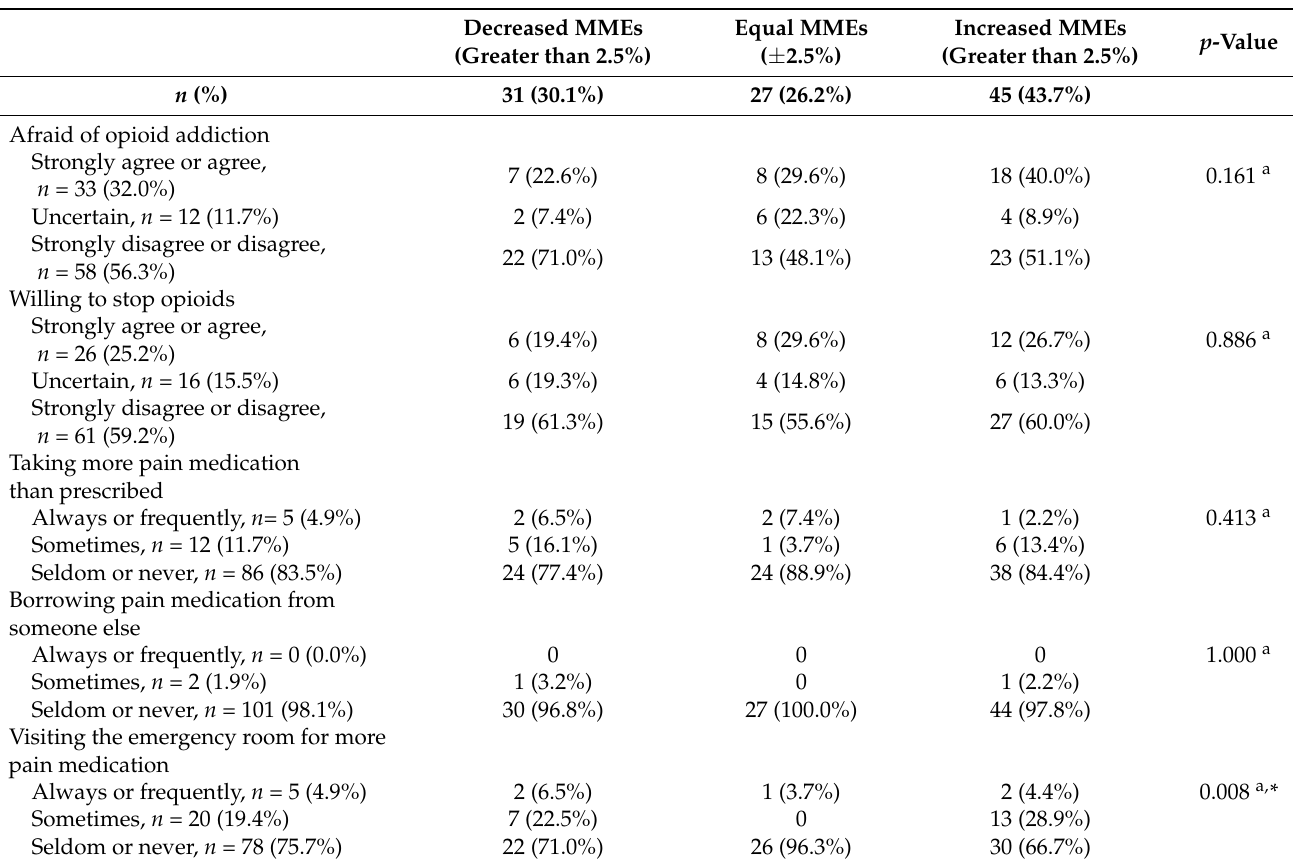
Table 4. Concerns regarding opioid discontinuation and misuse behaviors among 103 patients with long-term opioid therapy for chronic noncancer